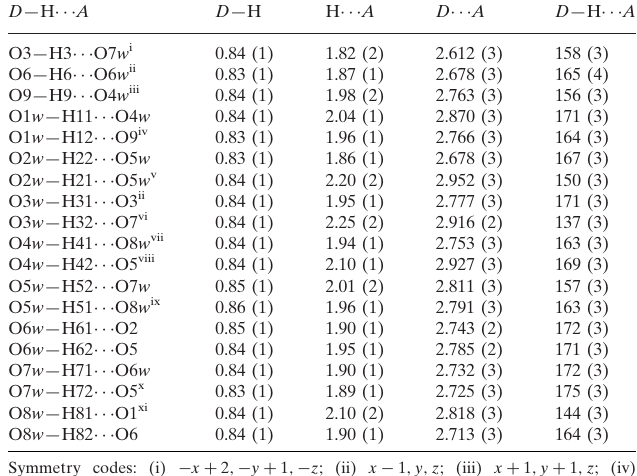
(C H O ) (H O) ] (cid:2) 10H O, 2 7 5 3 6 2 6 2 Hydrogen-bond geometry (A˚ , (cid:3) ). D —H (cid:2)(cid:2)(cid:2) A D